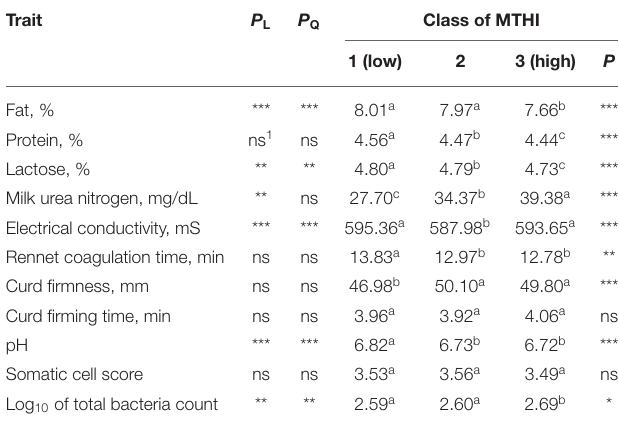
TABLE 5 | Significance of linear ( P L ) and quadratic ( P Q ) regression coefficient of maximum temperature-humidity index (MTHI) and least squares means of bulk milk traits for the fixed effect of MTHI with significance ( P ) of the effect (three